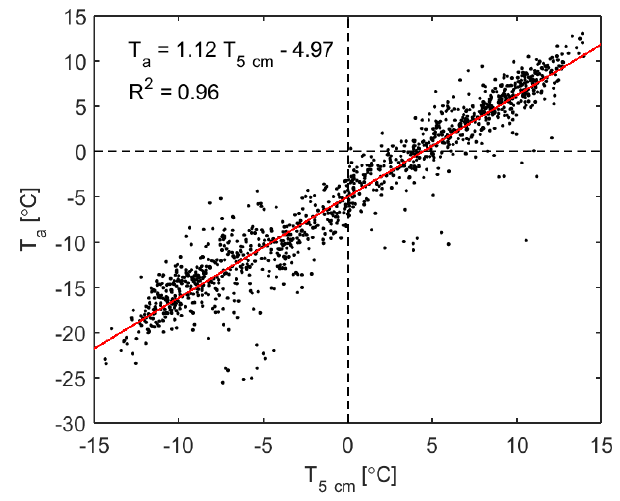
Figure 4. All available thermal profiles from 2007 to 2013. The temperatures at 1.5m are the mean annual air temperatures (MAAT). Note: missing years were caused by data gaps.